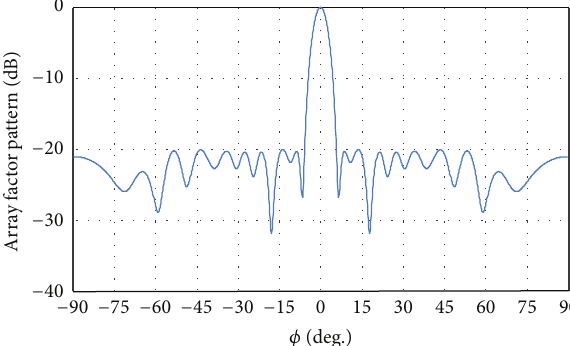
Figure 4: Number of iterations in relation to SLL with the real weight coefficient interval and SLL of [0 1] and <− 20 dB.